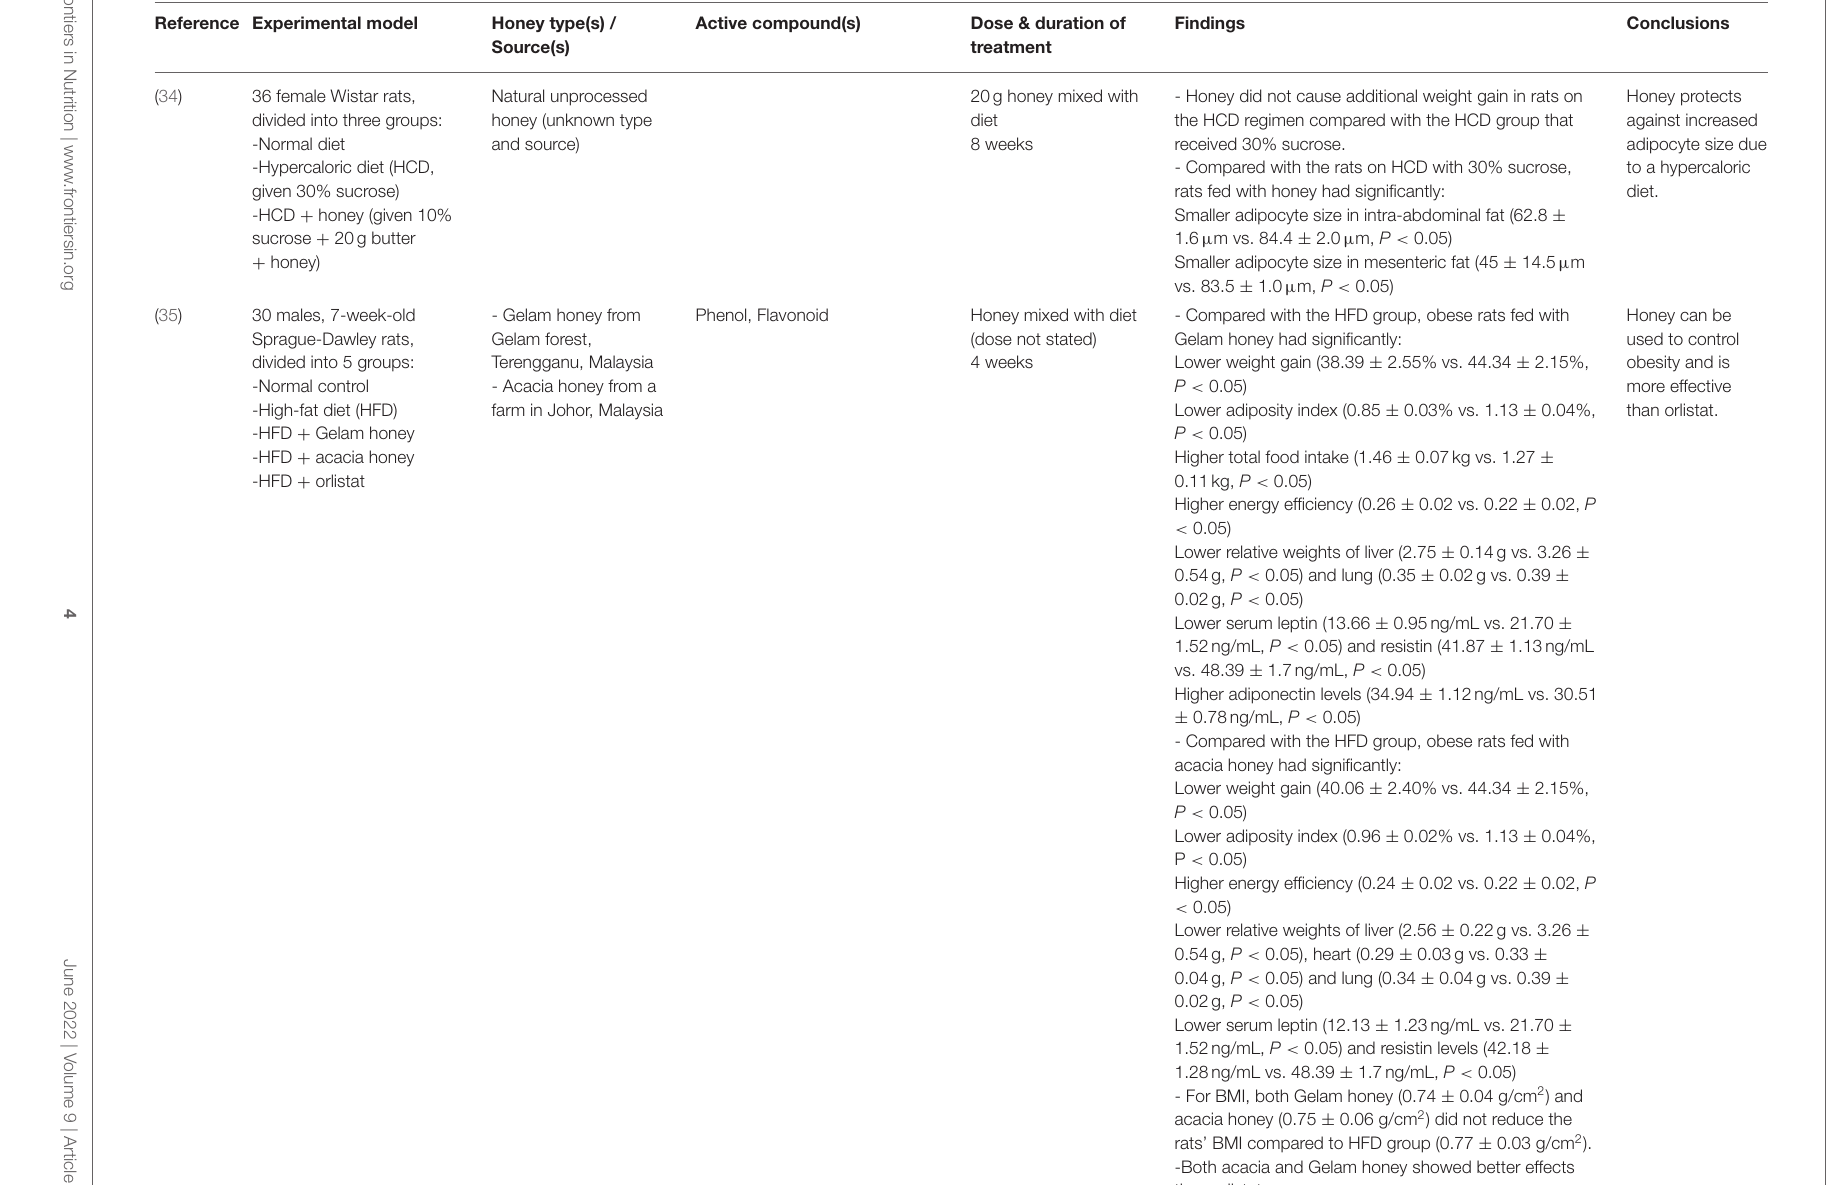
TABLE 1 | Characteristics of the included studies. Altogether, nine articles were used for data extraction, including six animal studies and three clinical